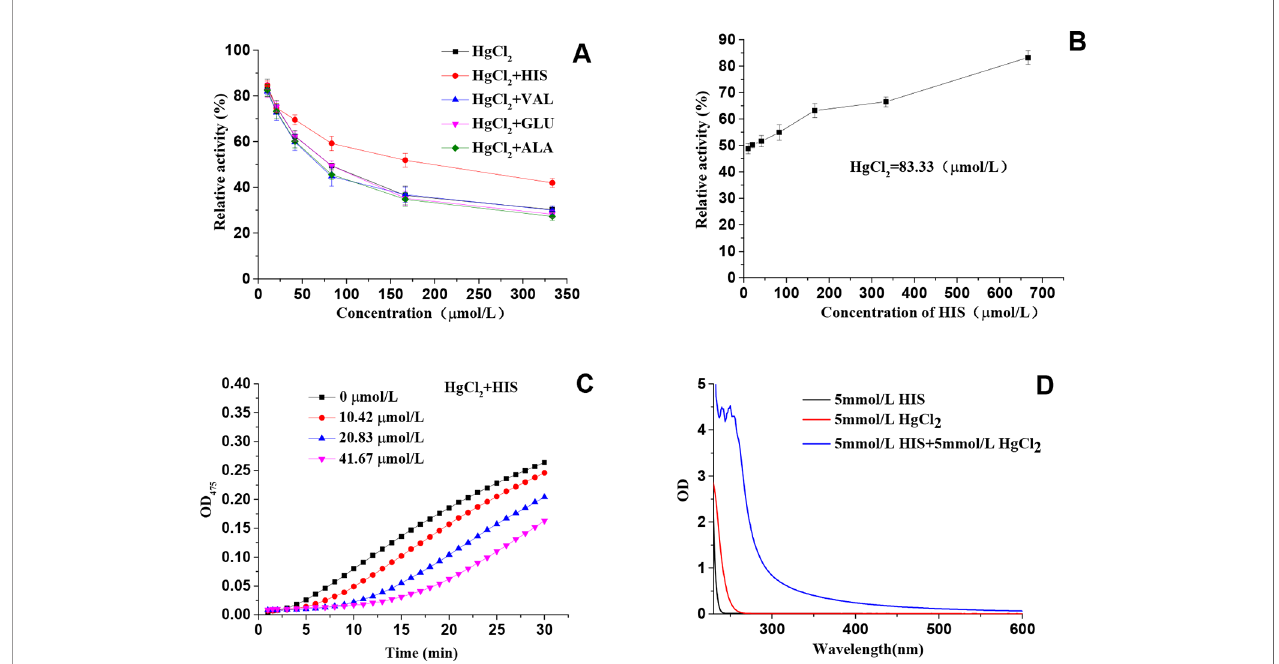
FIGURE 7 | (A) Effects of amino acids on protecting the diphenolase activity in the presence of HgCl 2 ; (B) The relationship between the protecting effects and the concentration of His; (C) Effects of His on protecting the monophenolase activity in the presence of HgCl 2 ; (D) The UV-Vis spectra of His, HgCl 2, and a mixture of both. The experiment was repeated three times (n =